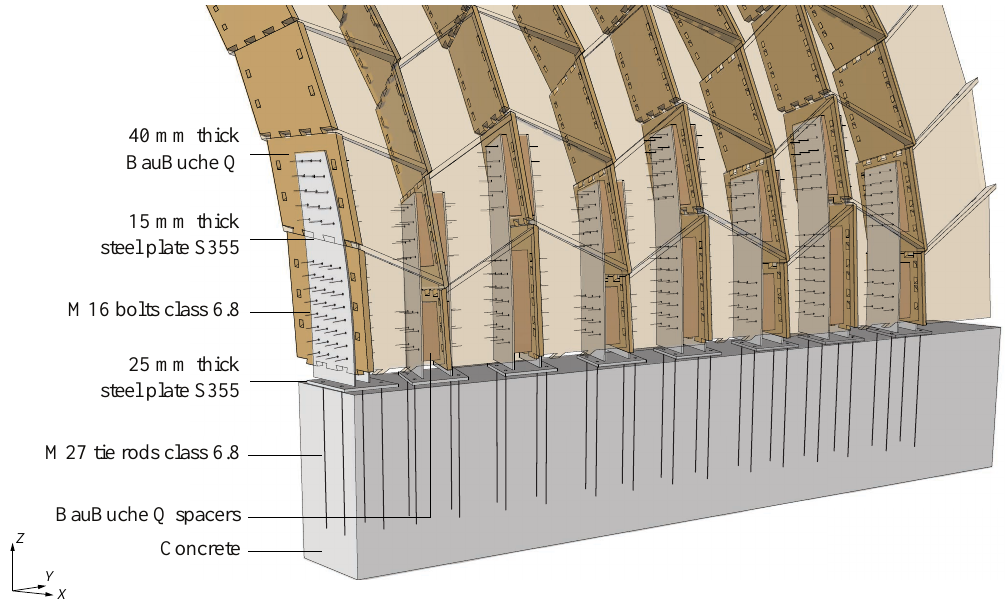
Figure 3. Supports of arch n°